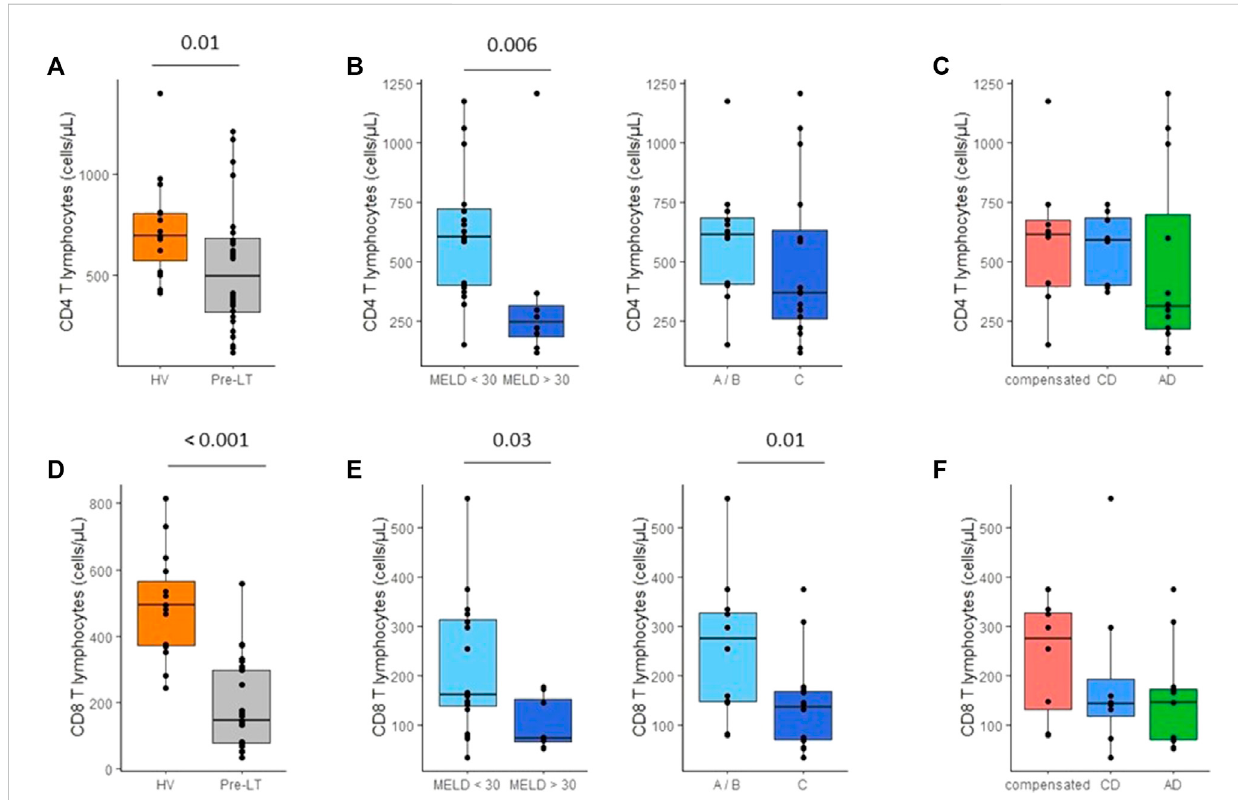
FIGURE 4 MonitoringofCD4+andCD8+Tcellcountsinperipheralbloodofpre-transplantpatients. (A) CD4+Tlymphocytescountinhealthyvolunteers(HV, n =15)and pre-transplant patients (pre-LT, n =28). (B) CD4+Tlymphocytescount inpatients withaMELDscore < 30( n =20)orwith aMELDscore ≥ 30 ( n = 8) and in patients with Child-Pugh score A or B (A/B, n = 12) or with Child-Pugh score C ( n = 16). (C) CD4= T lymphocytes count in patients with compensated cirrhosis ( n = 8), chronic decompensated cirrhosis (CD, n = 8). (D) CD8+ T lymphocytes count in healthy volunteers (HV) and pre- transplant patients (pre-LT). (E) CD8+ T lymphocytes count in patients with or without MELD score < 30 and in patients with Child-Pugh A/B or C. (F) CD8+ T lymphocytes count in patients with compensated, chronic decompensated, and acute decompensated cirrhosis. The nonparametric Wilcoxon test was used to assess differences between patients and HV and between patients ’ subgroups determined by MELD and Child-Pugh